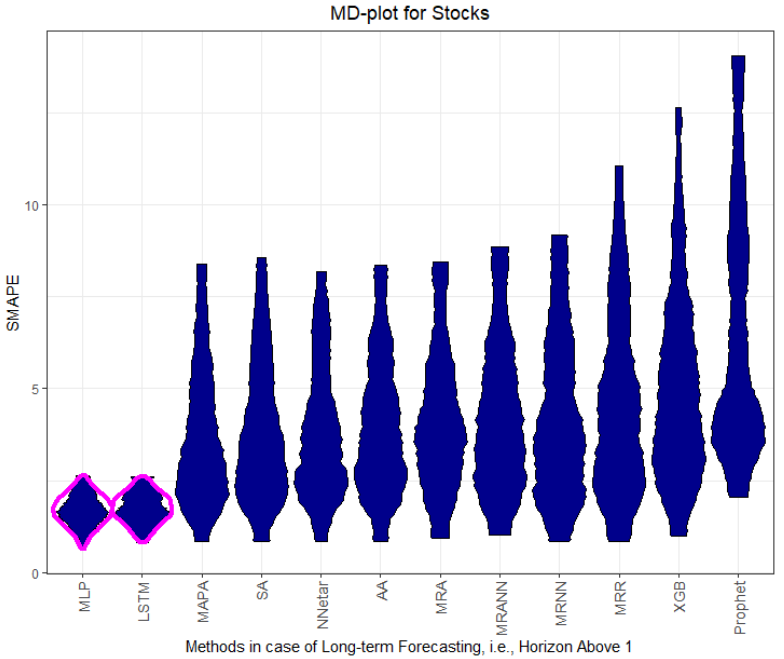
Figure A9. Mirrored density plot of Symmetric Mean Absolute Percentage Errors (SMAPE) computed with a rolling forecasting origin over all horizons on dataset Stocks. The estimated distributions showing a magenta marking are approximately gaussian distributed